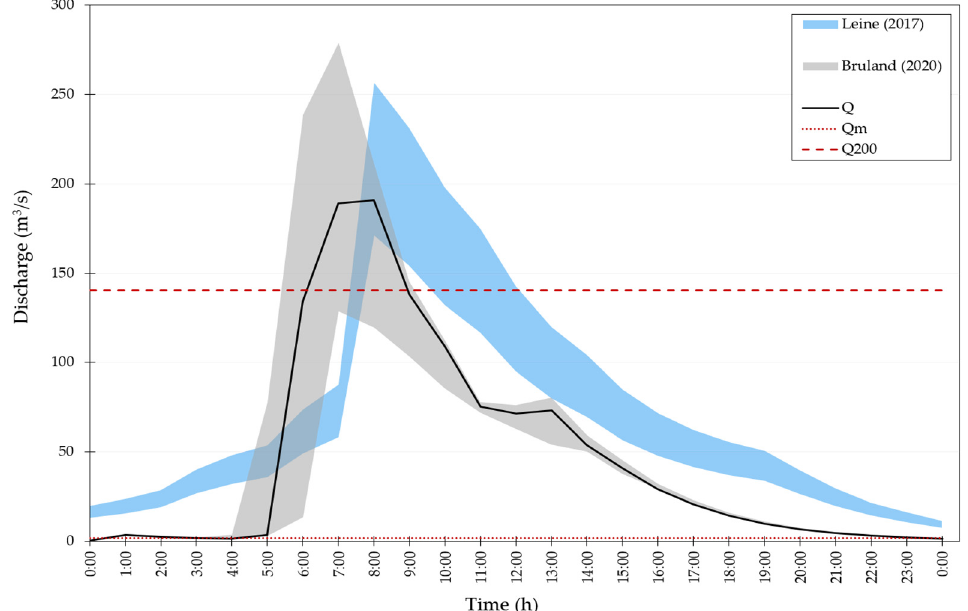
Figure 3. Discharge range proposed by Bruland [8] (gray area), with Q (black line) having the highest expectancy, and discharge range proposed by Leine [9] (blue area) for the 2017 flash flood. Red lines mark annual average Q mean (Q m ) and discharge for a return period of 200 years (Q 200 ) in the Storelva river [9].